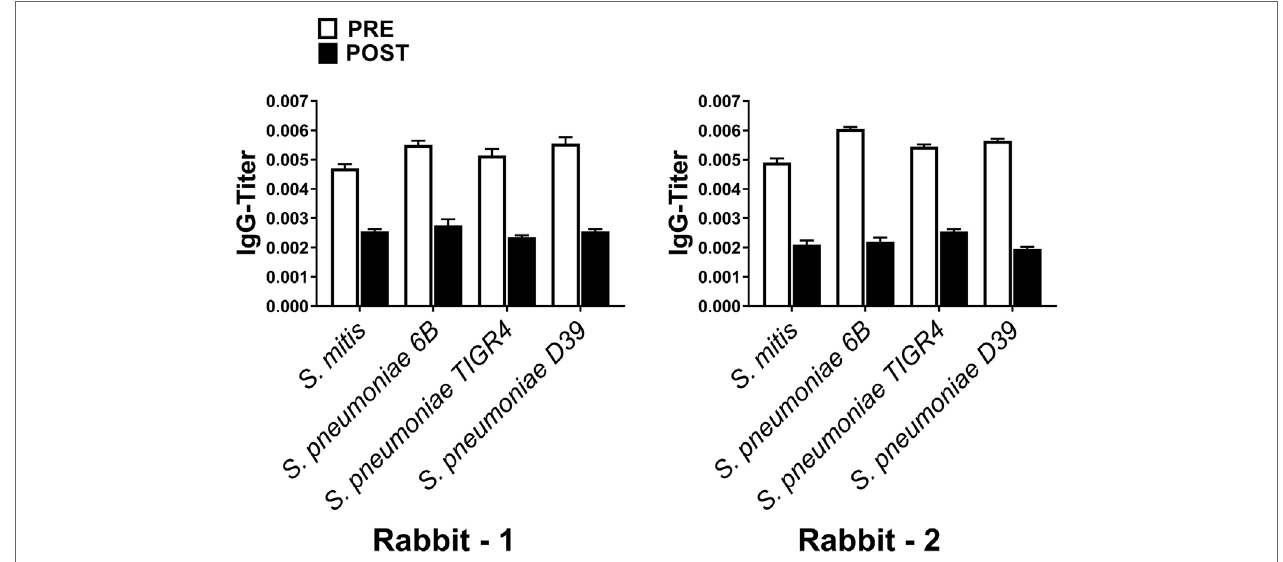
FigUre 2 | Levels of Streptococcus pneumoniae -reactive IgG antibodies from pre- or post Streptococcus mitis -immunized rabbits. The titer of IgG antibodies was determined using whole-cell ELISA. Antisera were used from rabbit-1 and rabbit-2, immunized with S. mitis CCUG31611. The serum samples were serially diluted, and the OD values converted to titers, with a cutoff of OD value of 0.40 (see Materials and Methods; low numbers indicate high antibody concentration, e.g., 0.002 = 1/500 and 0.004 = 1/250). The bars show averages of two replicates. Abbreviations: PRE, pre-inoculation sera; POST, post-inoculation sera.